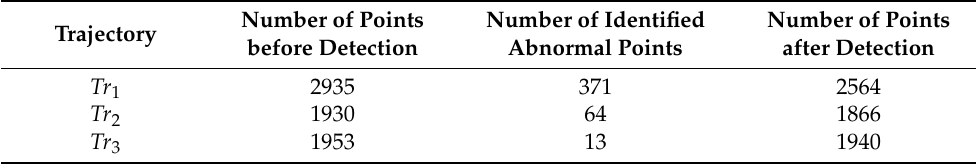
Table 6. Trajectory points in different states in the rule-based